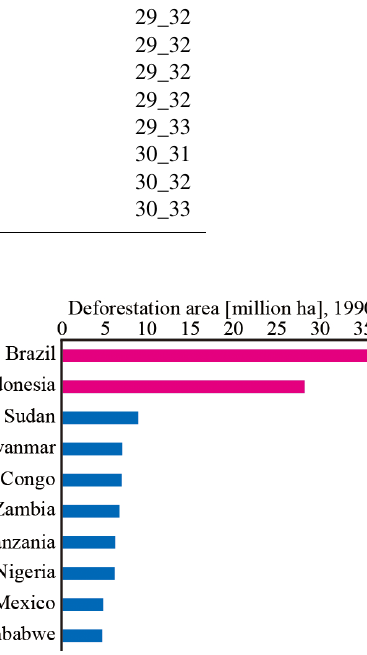
Figure 5. List of the top 10 countries for changes in deforesta- tion area (millionha) from 1990 to 2005. These were calculated with data from the Global Forest Resources Assessment 2005 (FAO,